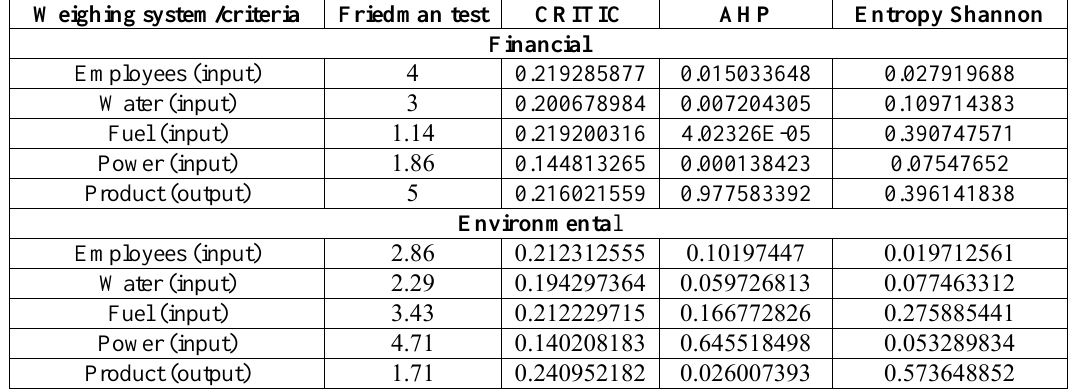
Table 8: The values of weights of variables in weighing systems of MCDM for both environmental and financial issues. Weighing system/criteria